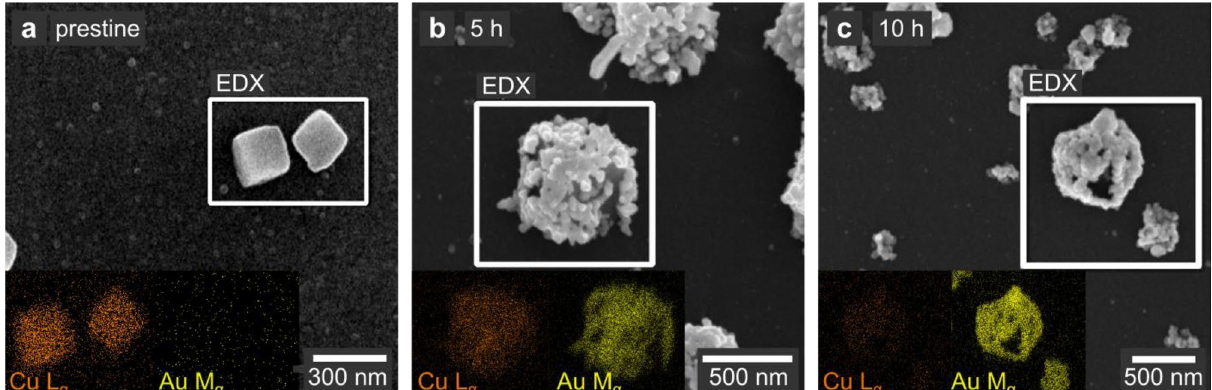
Figure 3. Ex situ study of the galvanic replacement of Cu 2 O with Au. SEM images and corresponding EDX maps (insets) of ( a ) pristine and ( b , c ) Cu 2 O nanocubes replaced with HAuCl 4 for 5 and 10 h, respectively. After 5 h ( b ), the GRR is still incomplete, with a grainy layer of Au particles growing at the surface of Cu 2 O. After 10 h ( c ), the GRR is complete, yielding hollow Au To start the replacement of Cu 2 O with Au, we mount one window with nanocubes at the exit position of the reactor together with one empty window and pre-fill the reactor with water. We slowly dose the reaction solution into the reactor and image the gradual replacement during 10 h. The scanning electron microscopy (SEM) images in Fig. 3 depict the changes in the particle morphology during the GRR. Even though the size of the nanocubes varies between these ex situ experiments, we observe the deposition of individual Au particles with different shapes on their surface. While after 5 h reaction time (Fig. 3b), the Cu 2 O template underneath the Au deposition is still visible, we observe an Au nanocage with a hollow interior after 10 h (Fig. 3c). At this stage, a continuous yet porous Au layer resembling the original cubic